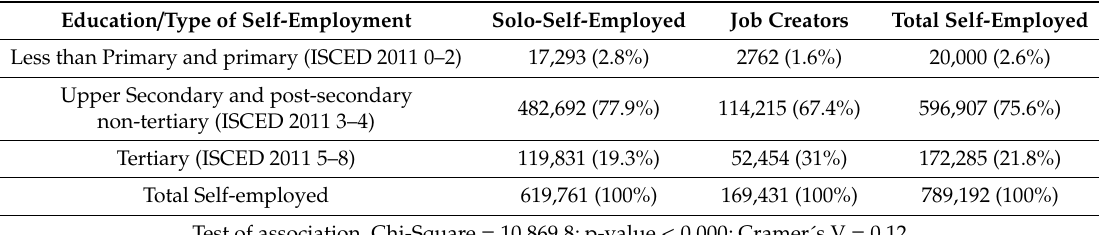
Table 3. Association between education level and type of self-employment (age range 15–64 years; absolute numbers and column percentage shares in